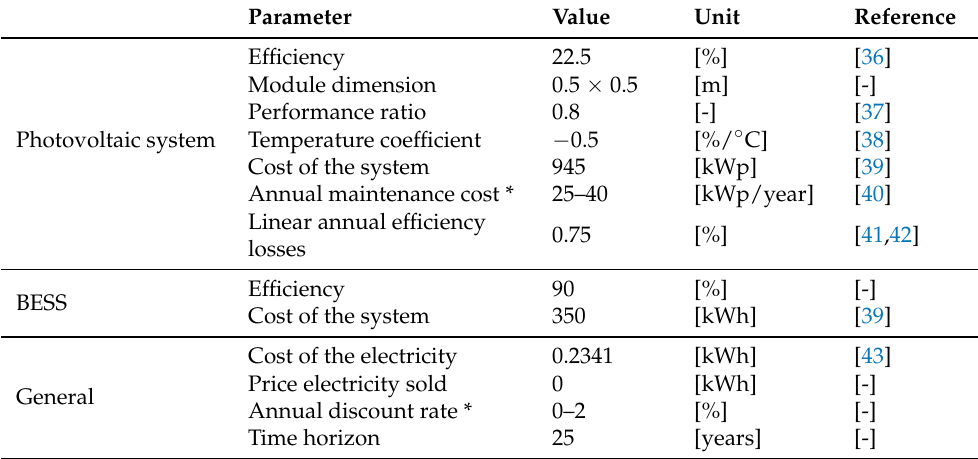
Table 2. Inputs used for the optimization tool. Values indicated with ∗ are stochastic variables that have been considered uniformly distributed in the indicated